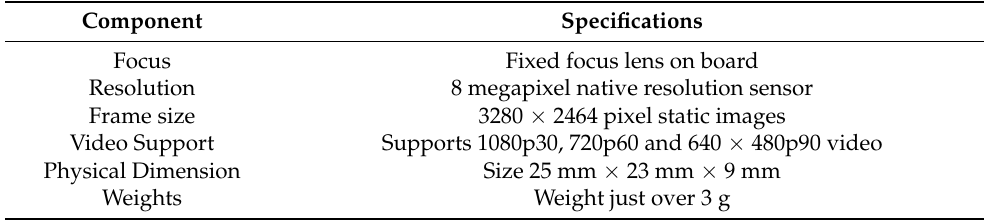
Table 5. Raspberry Pi RGB camera